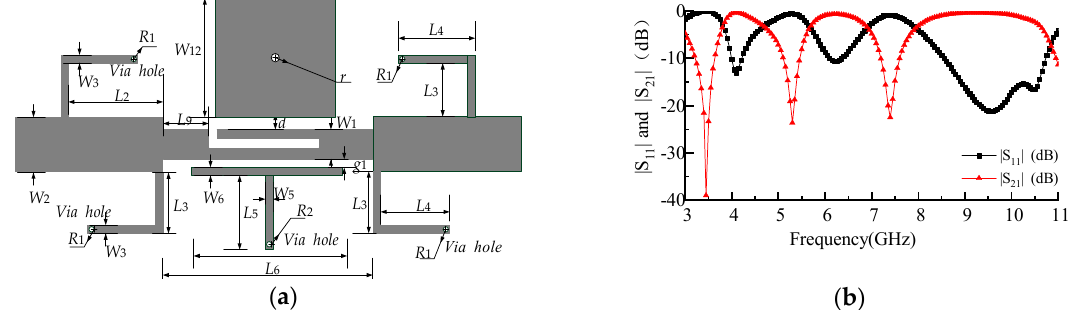
Figure 10. ( a ) The circuit of the triple notches bandstop microstrip filter using MEBG; ( b ) the simulation results of the proposed filter by using HFSS.